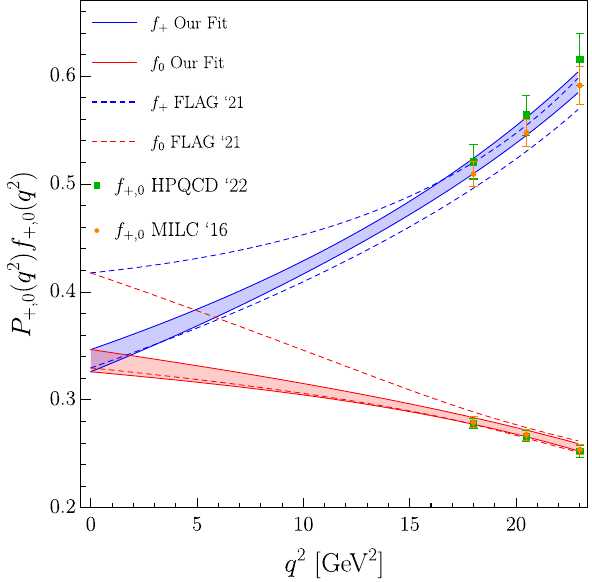
Fig. 1 The results of our fit for f + ( q 2 ) and f 0 ( q 2 ) form factors are depicted by the blue and red solid curves respectively. The dashed lines correspond to the results reported by FLAG [35]. The synthetic data points by HPQCD (green) [33] and by FNAL/MILC (orange) [34] are also shown for comparison. P + , 0 ( q 2 ) are the inverse pole terms defined in Eq.